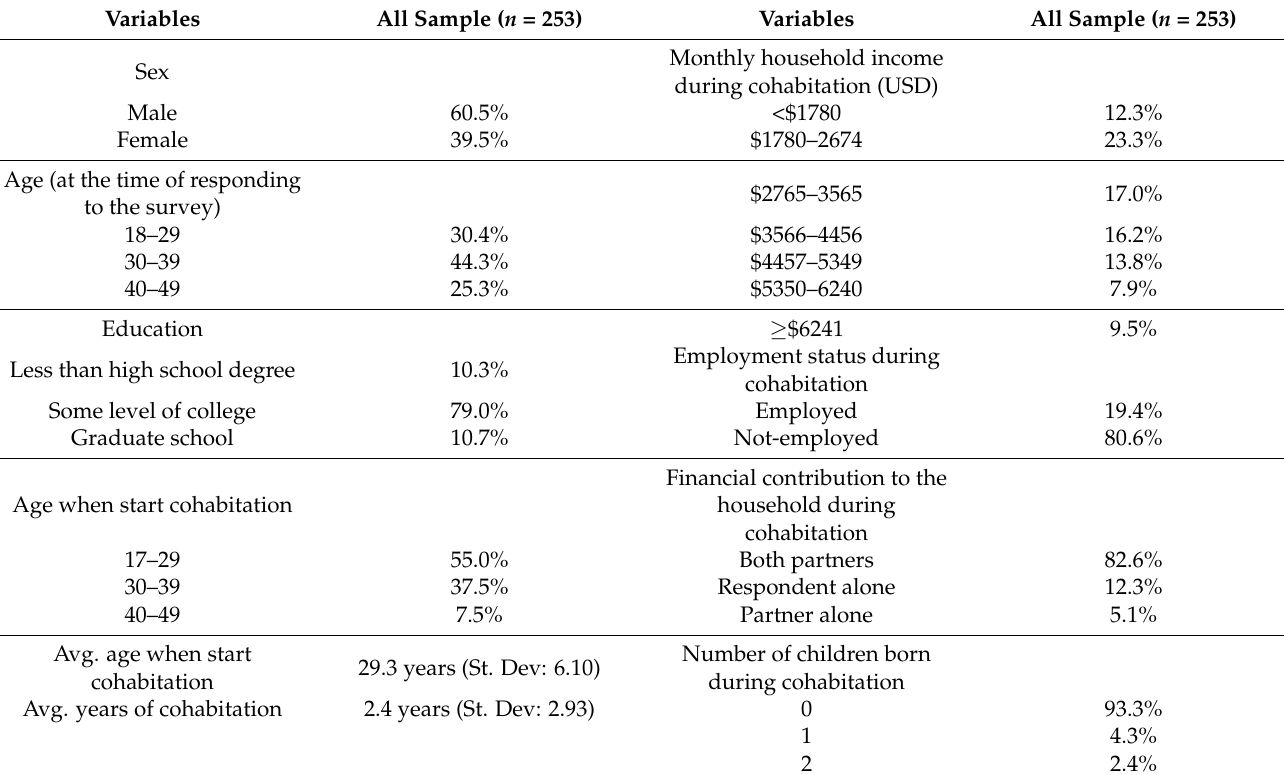
Table 1. Characteristics of online survey respondents